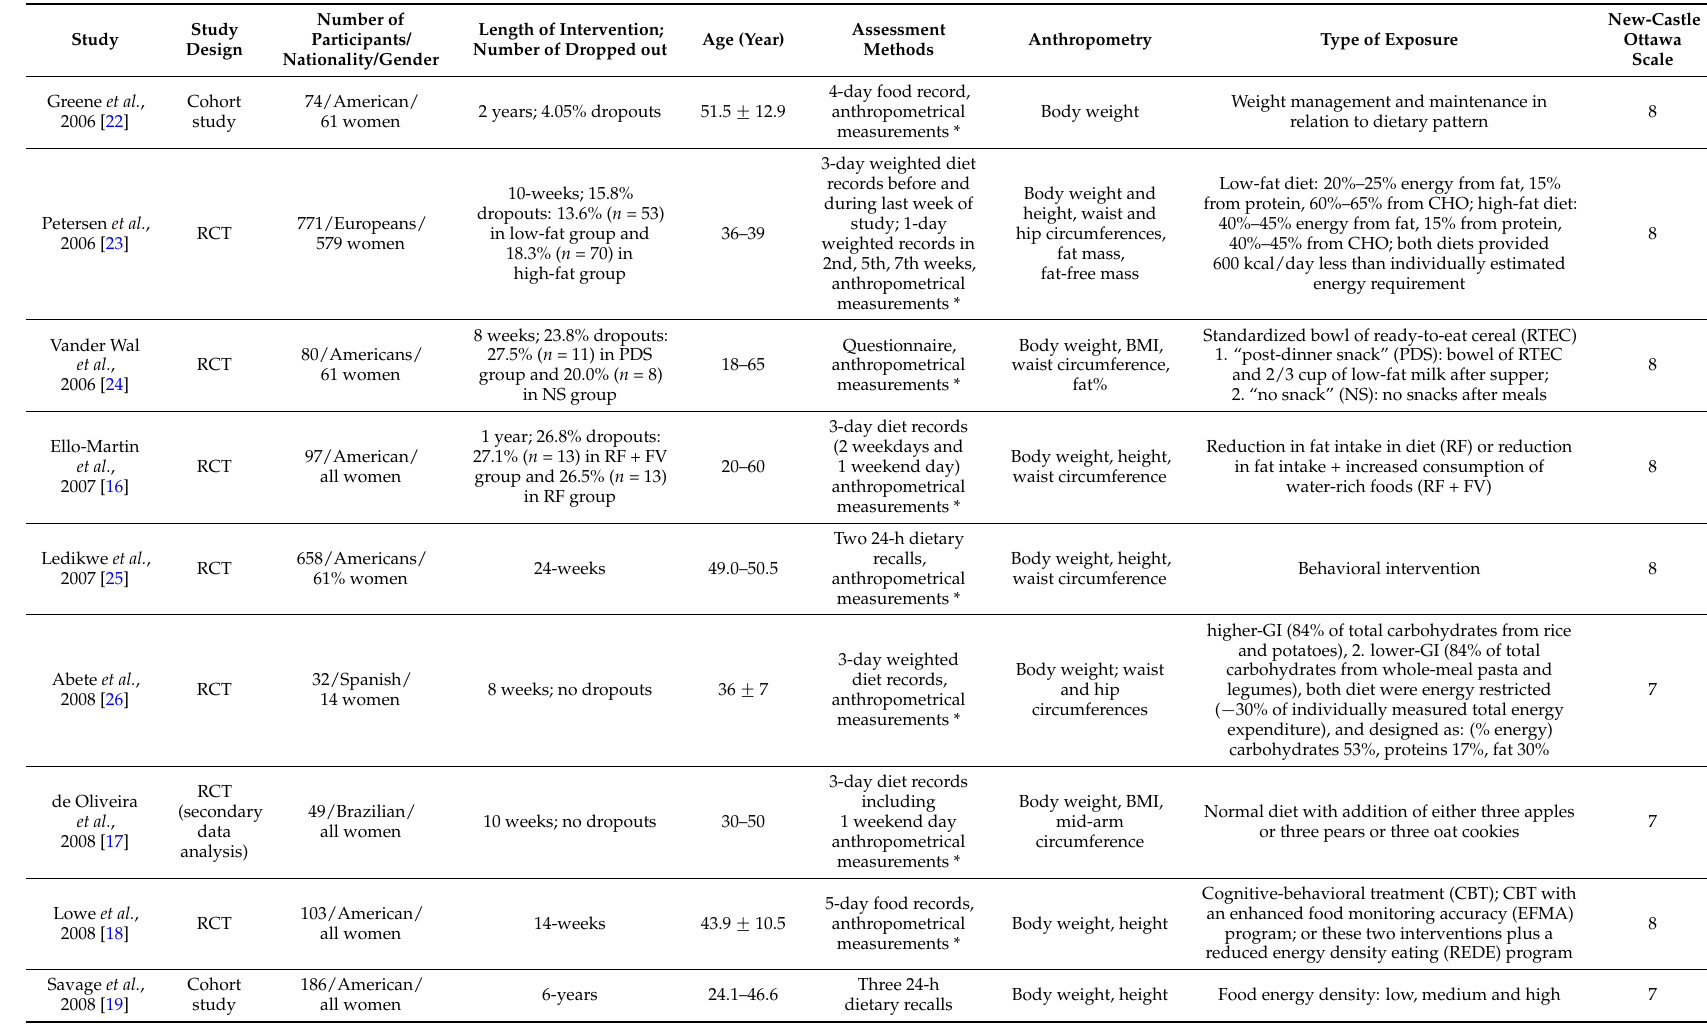
Table 1. Studies ( n = 13) and population characteristic ( n =